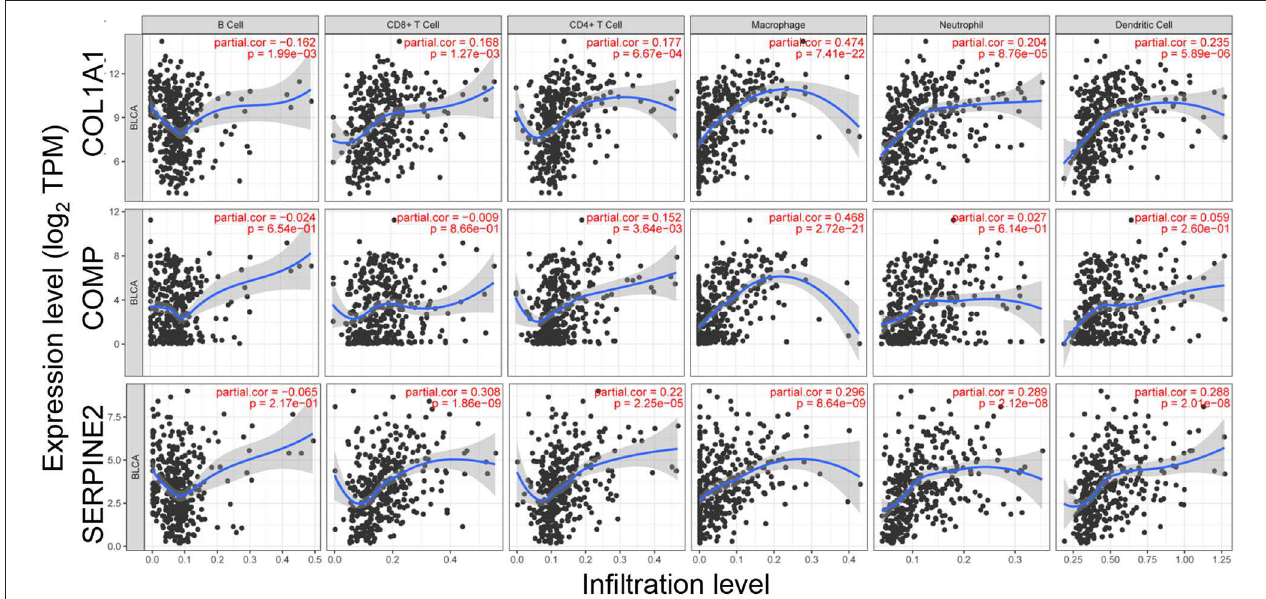
FIGURE 6 | Correlation of prognostic genes’ expression with immune infiltration